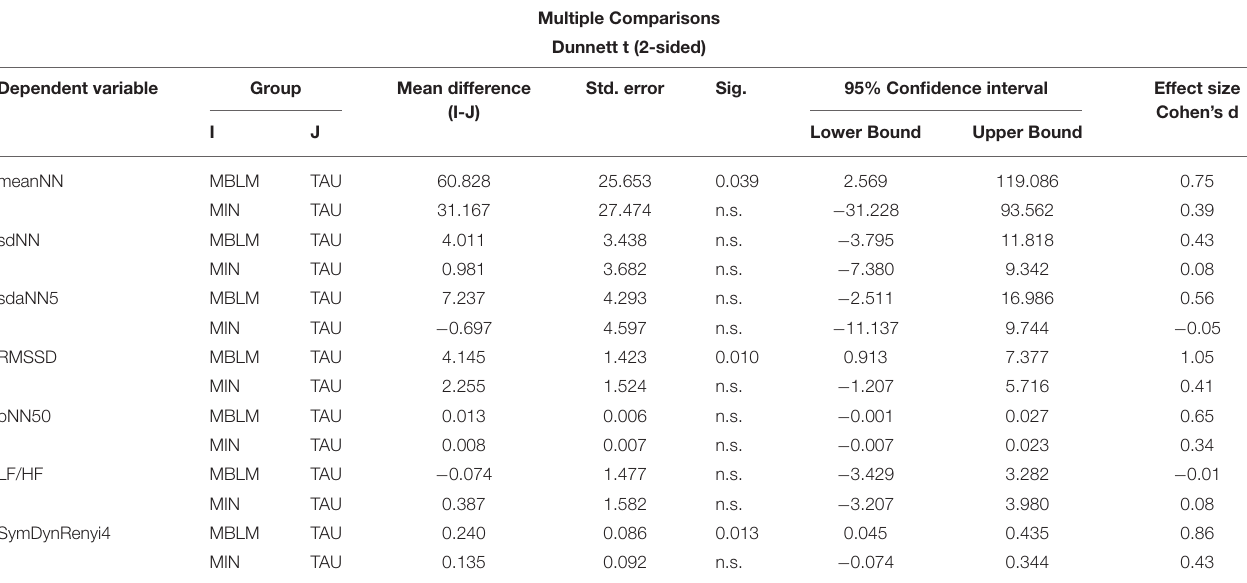
TABLE 3 | Results of the observed data in multiple comparison testing between the pre-to-post differences of the three groups MBLM, MIN, and TAU. Multiple